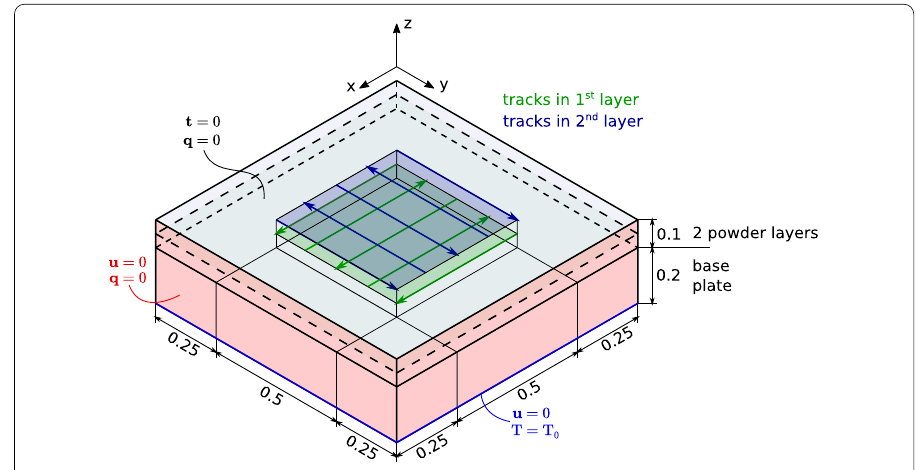
Fig. 21 Geometry, boundary conditions and simulation setup for two layer example with multiple tracks per layer (indicated in green for layer 1 and blue for layer 2). Dimensions in